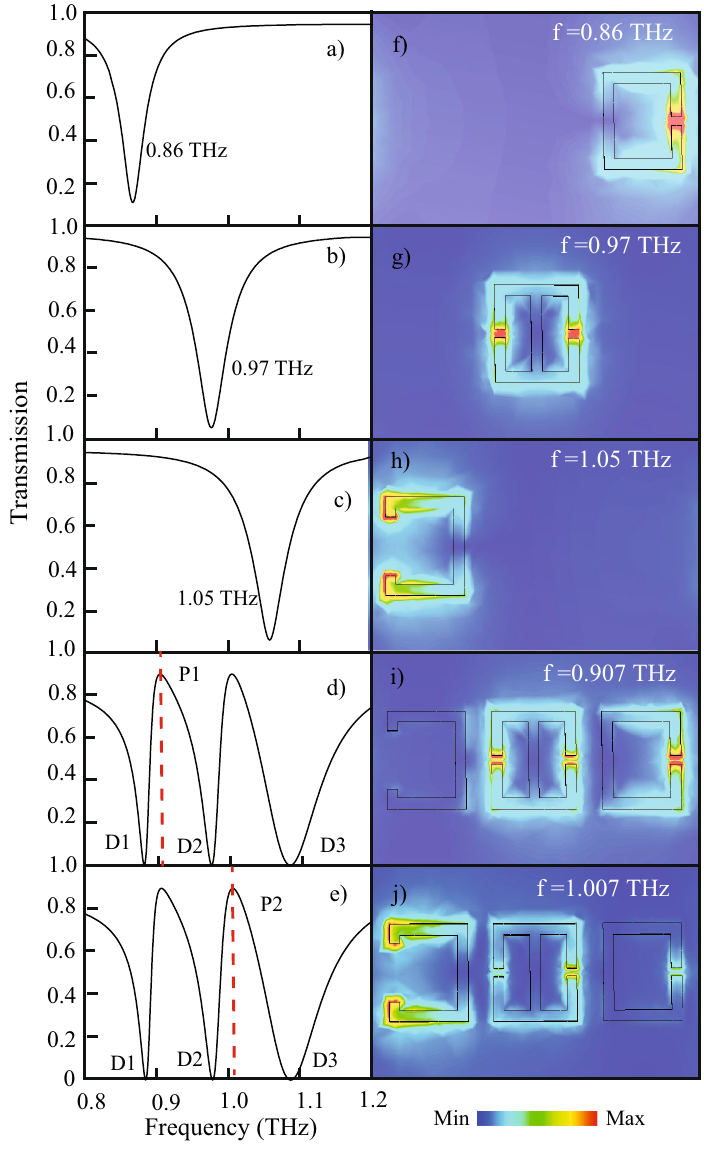
Figure 2. The transmission spectra for ( a ) the right CSRR indictating individual resonance at 0.86 THz ( b ) the mid TSRR demonstrating resonance at 0.97 THz ( c ) the left CSRR showing resonance at 1.05 THz ( d ) and ( e ) the proposed combined MM configuaration at d = 10 µ m . The dotted red lines indicate the transmission profiles at the 1 st and 2 nd transparency peaks P1 and P2 respectively. Multiband EIT is observed with peak frequencies indicated by red dotted lines at P1 and P2. ( e ) Peak P2 of the EIT window at 1.07 THz. ( f ) Electric field profile showing right CSRR excited at 0.86 THz. ( f – h ) show induced electric field profiles for individual ( g ) TSRR excited at 0.97 THz left CSRR excited at 1.05 THz. ( i ) electric field profiles at peak P1 (0.907 THz) showing excitation of the TSRR and right SRR indicating coupling between the two. ( j ) Electric field profile corresponding to peak P2 (1.007 THz) showing excitation of left CSRR and